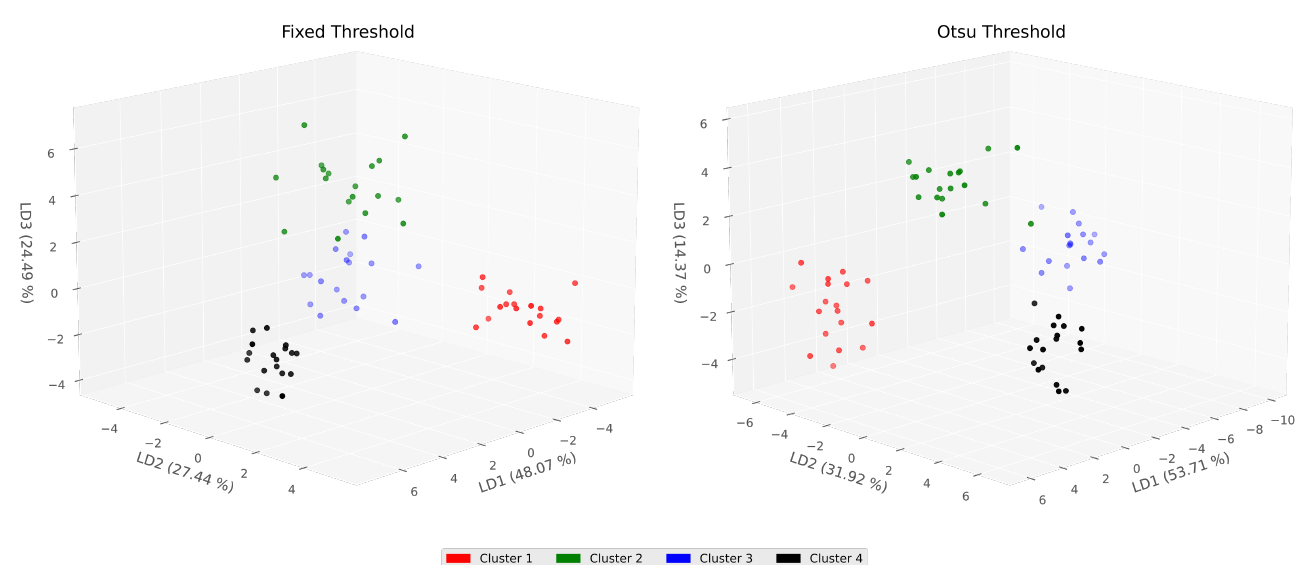
Figure 10. 4-cluster k -means for a low dimensionality representation (LDA) of multilayer graph metrics, on the left for the fixed threshold and right for the Otsu’s threshold. The four estimated clusters mapped to the imaginary movements in the window 3.5–5.5 s studied in the present work.